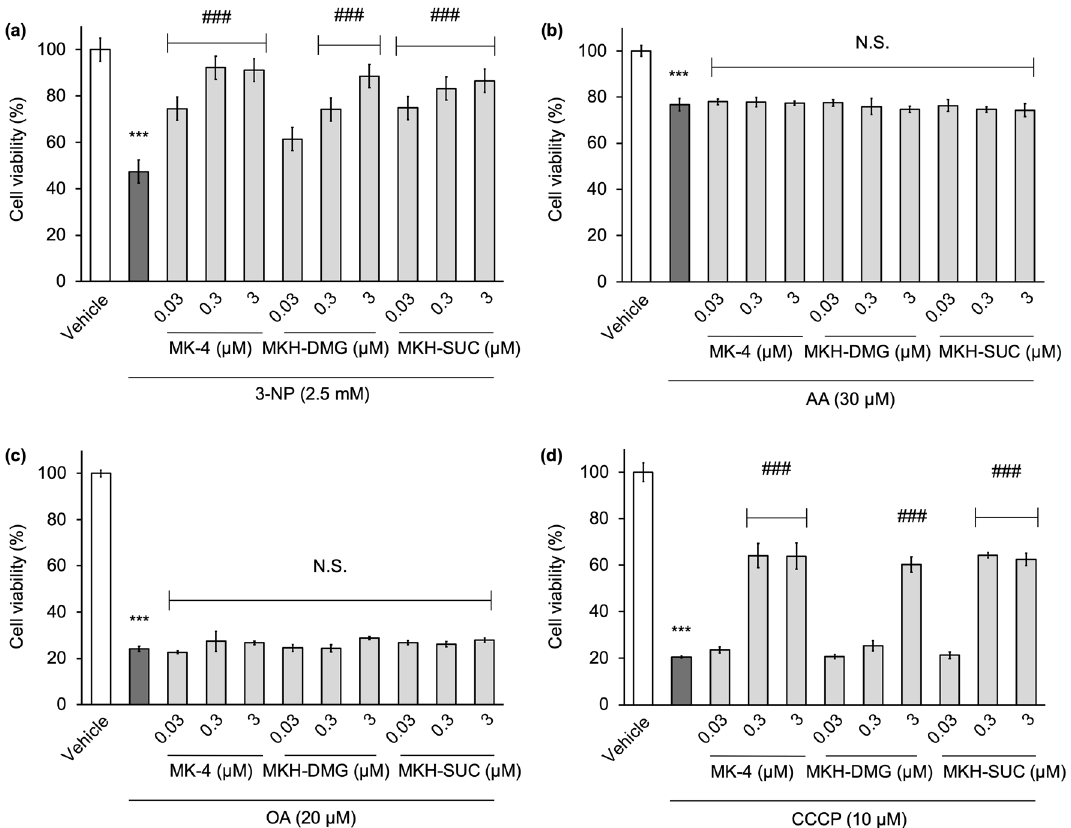
Figure 8. Influence of MK-4 and MKH derivatives on cell death induced by complex-II, III, V, and depolarization mitochondrial inhibitors. The NIH/3T3 cells were treated with 0.03 ‒ 3 µM MK-4, MKH-DMG, or MKH-SUC for 24 h in the presence of ( a ) 2.5 mM 3-NP, ( b ) 30 µM AA, ( c ) 20 µM OA, and ( d ) 10 µM CCCP. Cell viability was determined using CTB assay. ***p < 0.001 versus vehicle group; ### p < 0.001 versus 3-NP only group or CCCP only group; no significant (N.S.) versus AA only group or OA only group (Tukey’s test). Data are presented as mean ± SD (n =